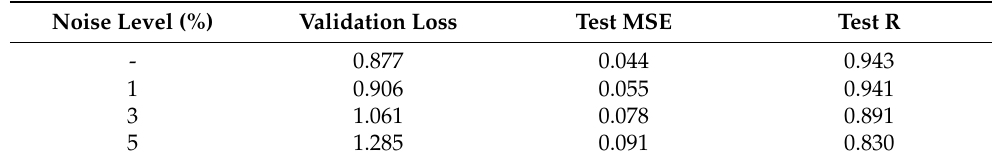
Table 2. Performance evaluation results.